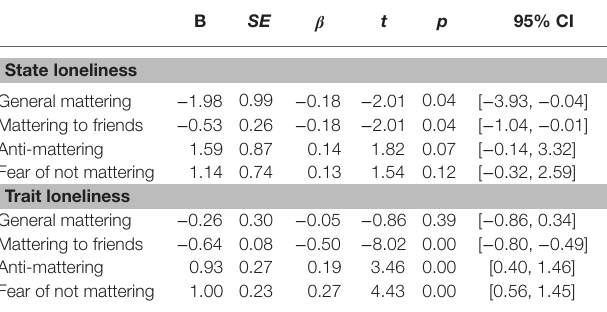
TABLE 2 | Multiple regression analyses predicting state and trait